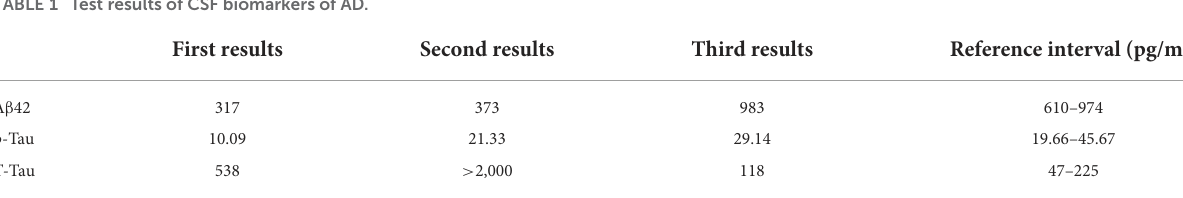
TABLE 1 Test results of CSF biomarkers of